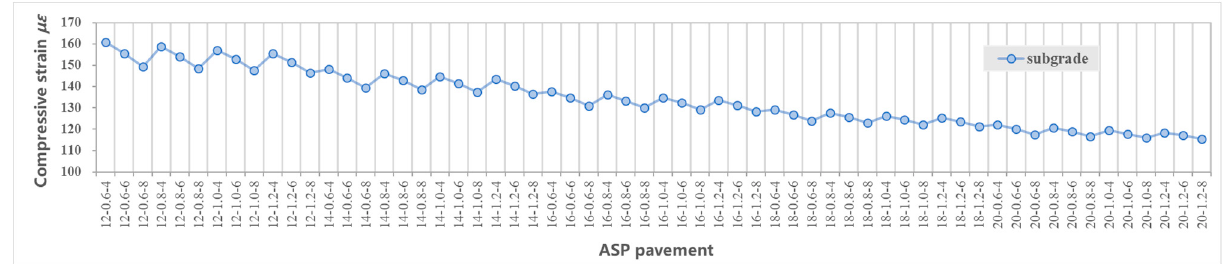
Figure 6. Compressive (vertical) strain at the top of subgrade (note: compressive (vertical) strain is negative).